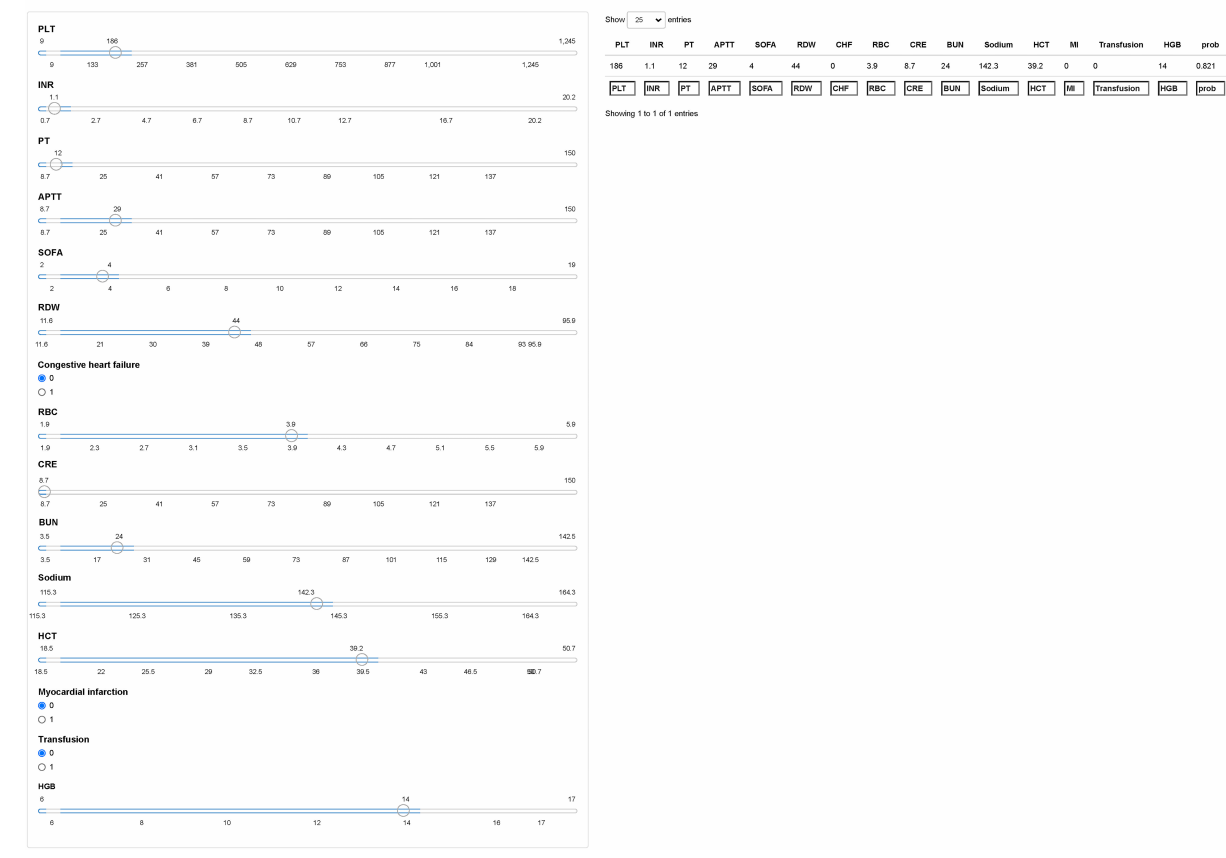
FIGURE 6 | Examples of website usage. Entering the input value determined the coagulopathy and displayed how each value contributed to the prediction. PLT, platelet; INR, international normalized ratio; PT, prothrombin time; APTT, activated partial thromboplastin time; SOFA, sepsis related organ failure assessment; RDW, red blood cell volume distribution width; RBC, red blood cell; CRE, creatinine; BUN, blood urea nitrogen; HCT, hematocrit; HGB,